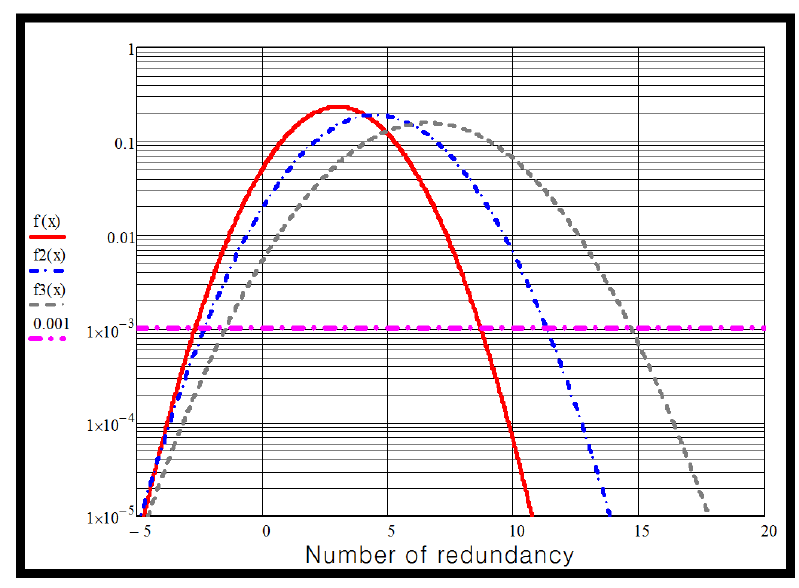
Figure 8. Unavailability function for MMC valve with failure rate of DC/DC converter = 500.